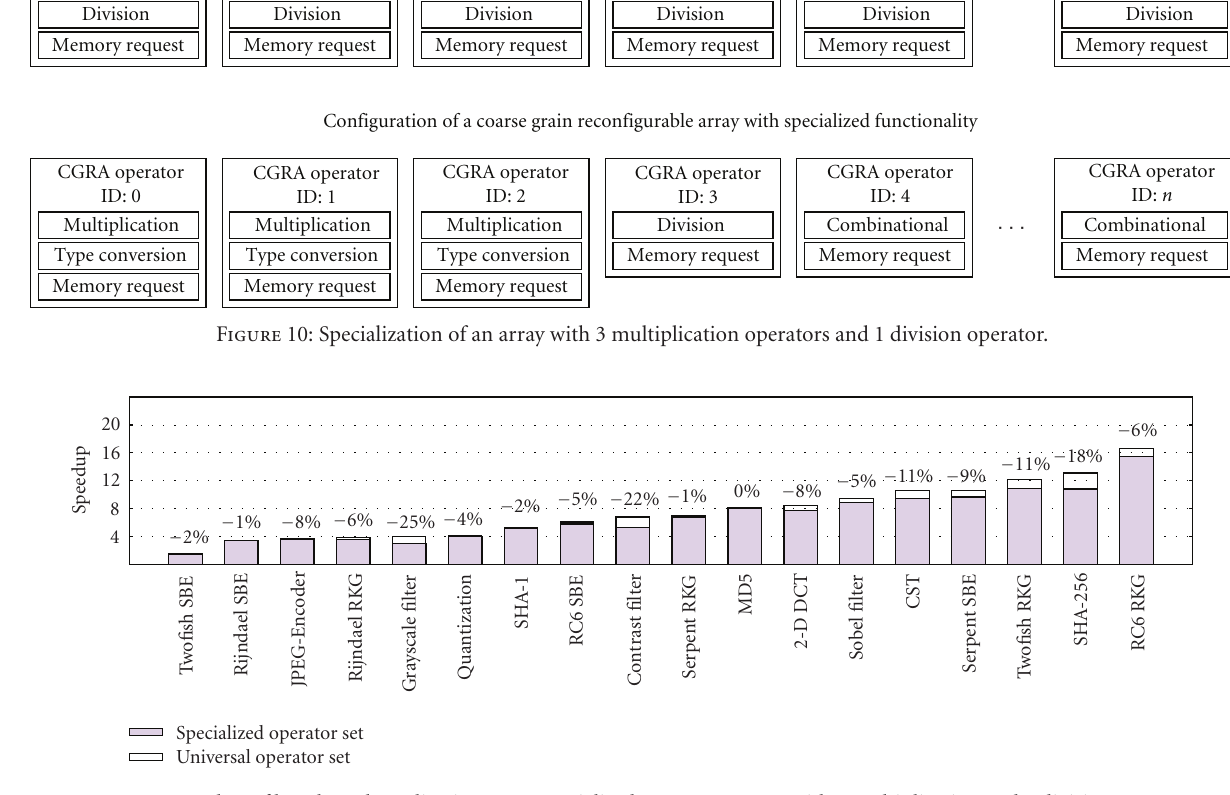
Figure 11: Speedup of benchmark applications on a specialized 4 operator array with 1 multiplication and 1 division